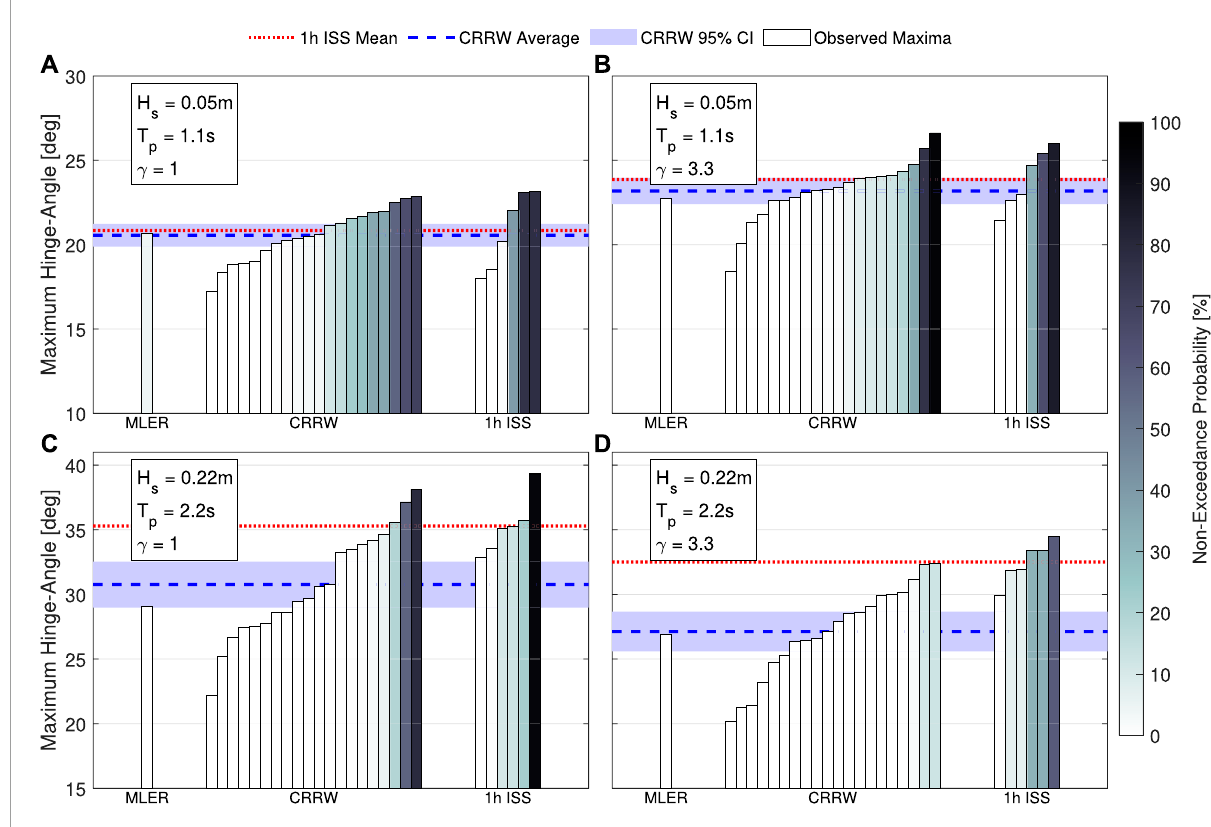
FIGURE 9 Maximum hinge-angle response obtained from the single and constrained SDWs, and irregular sea states. The average maximum response from each of the CRRW runs is also presented (blue dashed lines), along with the 95% confidence interval (shaded region), and average maxima from the 1-h irregular sea state. Each bar is coloured based on the non-exceedance probability. Each subplot (A–D) is a different sea states (parameters shown in the top left).